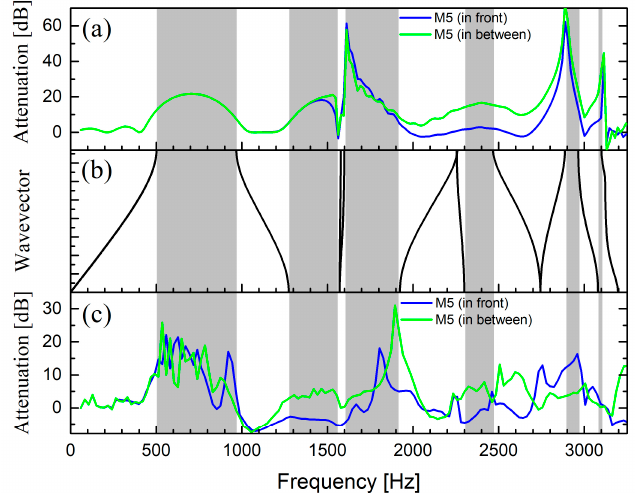
Figure 5. Attenuation spectra calculated for an acoustic barrier consisting of three rows of rigid cylinders arranged in a square configuration with a lattice constant of 22 cm and a volume filling ratio of 41%. ( a ) Results for incident plane waves; ( b ) band dispersion relation along the ΓΧ direction. Grey zones define band gaps along this particular direction; ( c ) results for impinging cylindrical waves.